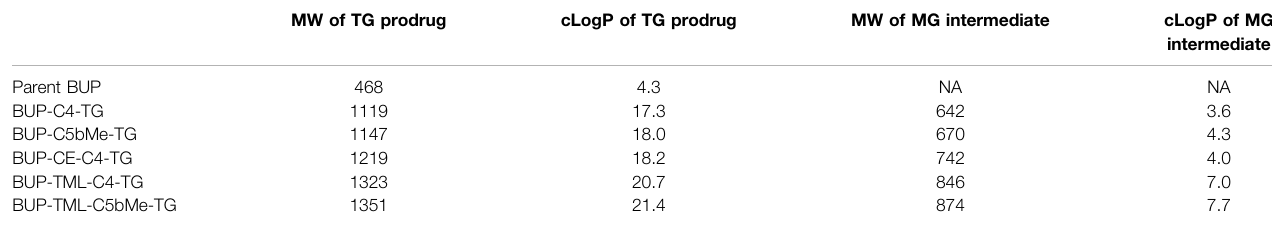
TABLE 1 | Molecular weight (MW) and cLogP values of BUP, prodrugs, and expected MG-like intermediates generated upon hydrolysis by digestive fl uid in the GI lumen. Data were calculated OSIRIS Datawarrior (Version 5.5.0). MW of TG prodrug cLogP of TG